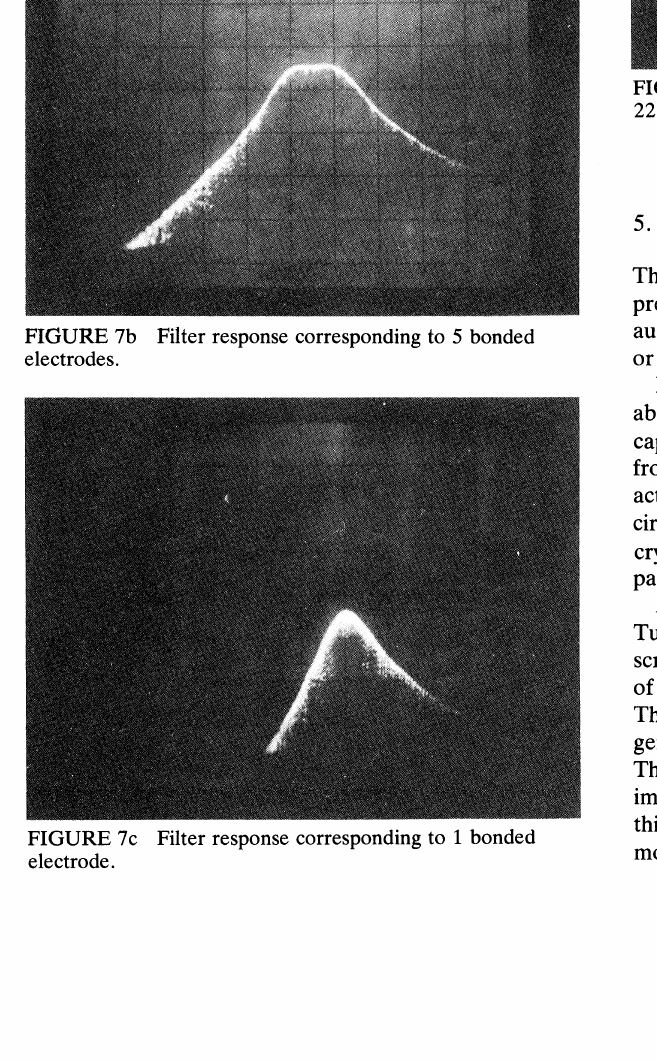
FIGURE 7a FiIter response corresponding to 6 bonded electrodes.